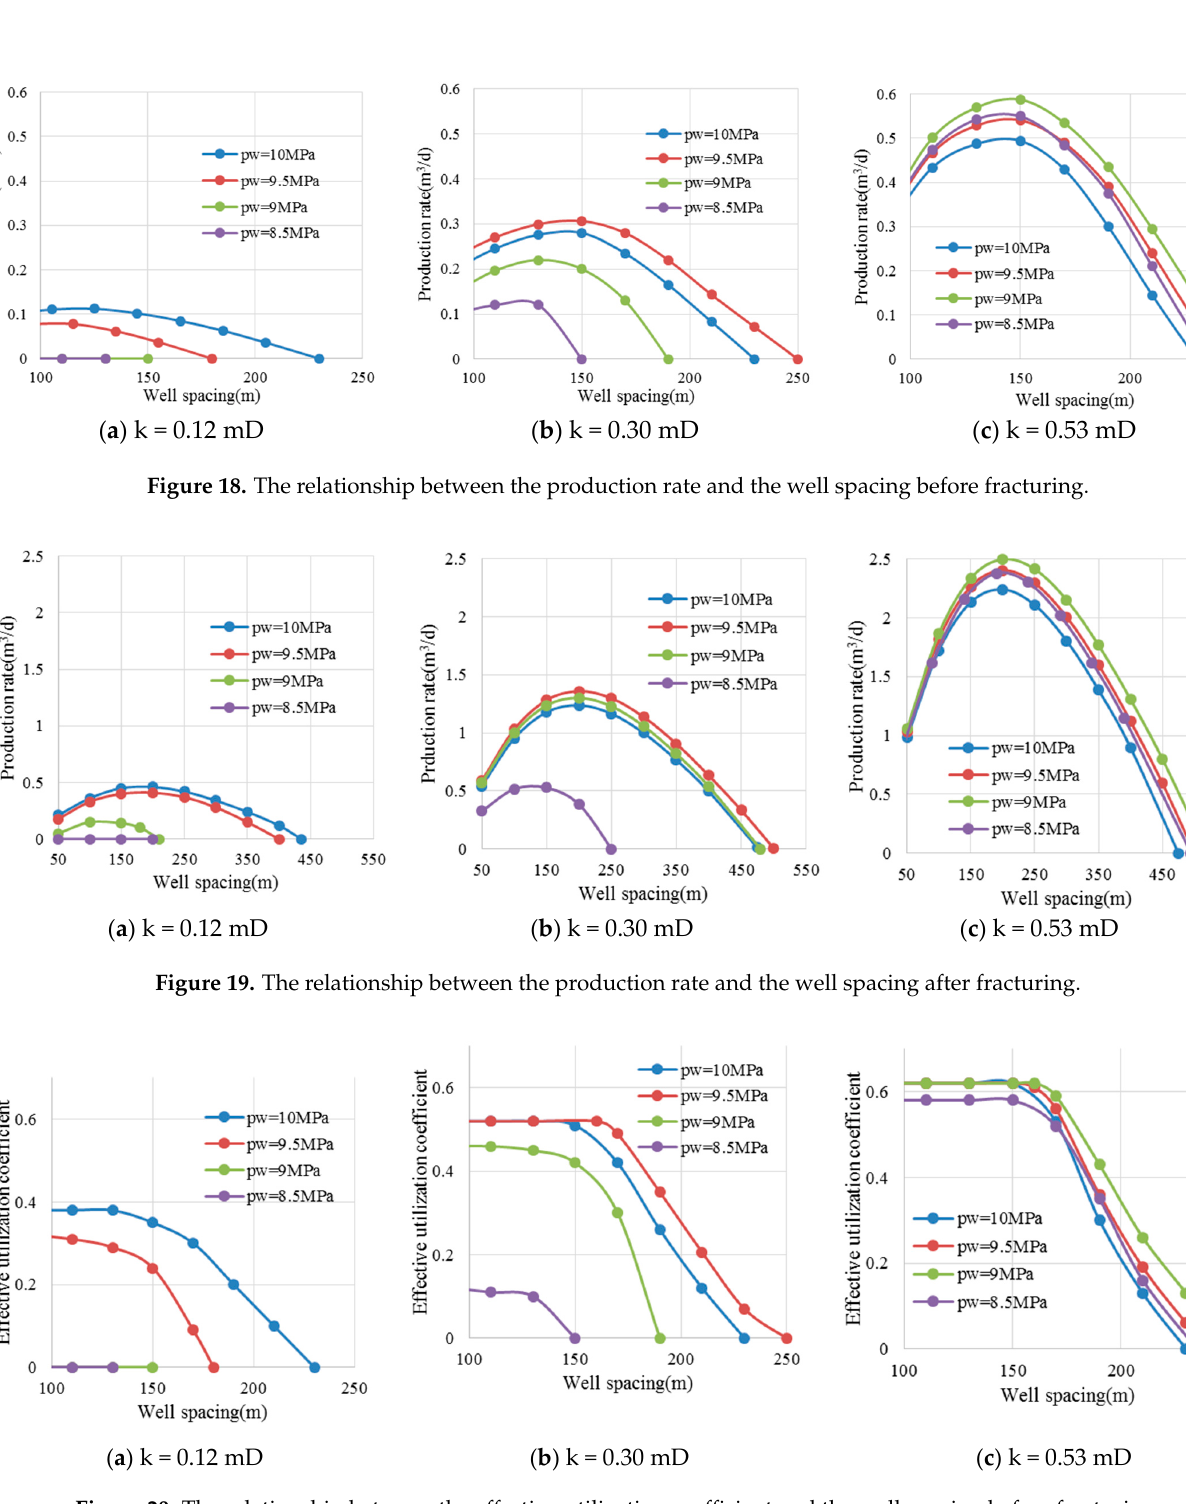
Figure 17. The relationship between the effective utilization coefficient and the production well pressure after fracturing.